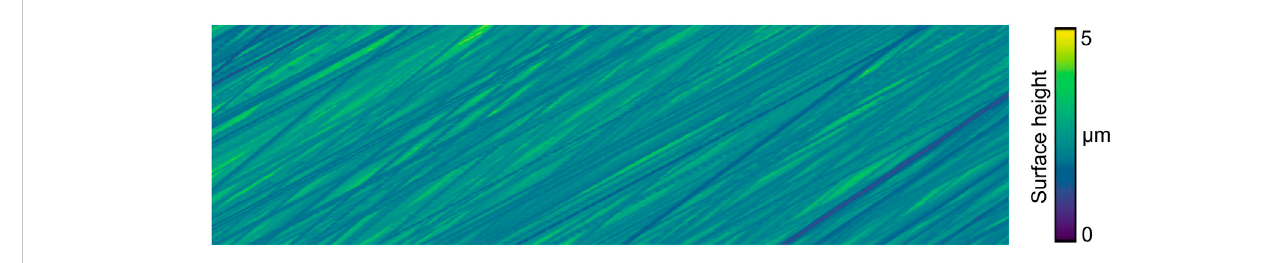
FIGURE 3 Simulated surface of a honed workpiece of an exemplary honing process.